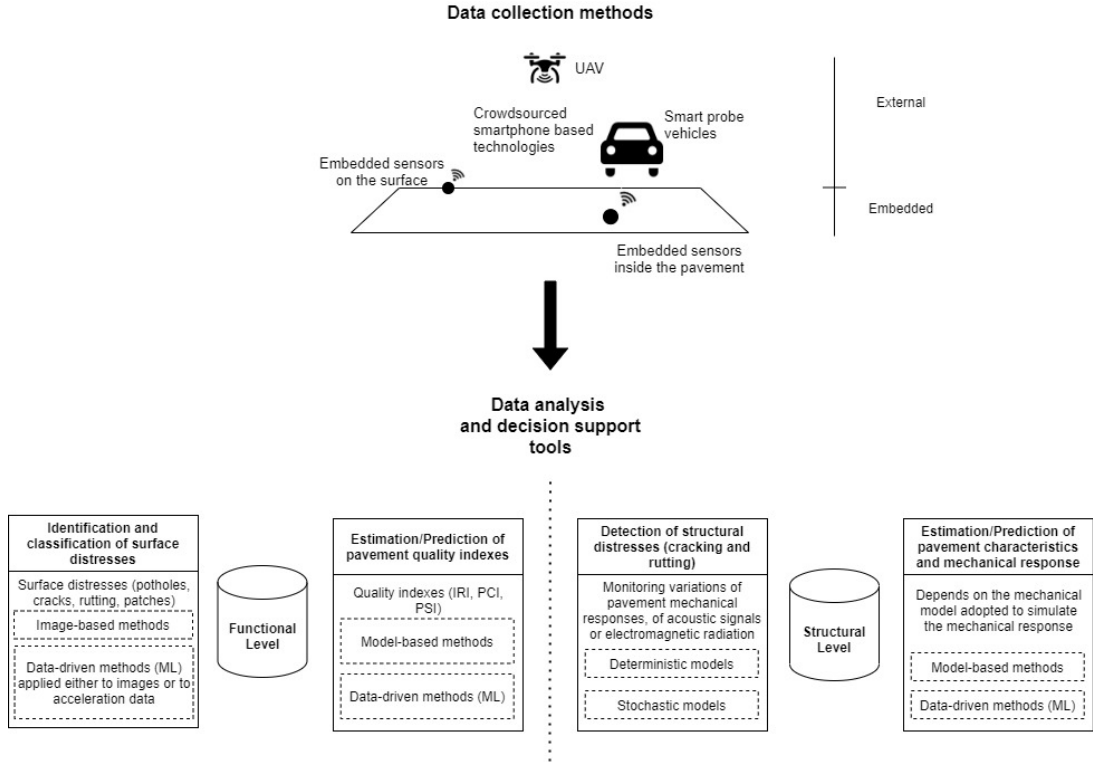
Figure 1. Decision support system for smart pavements.